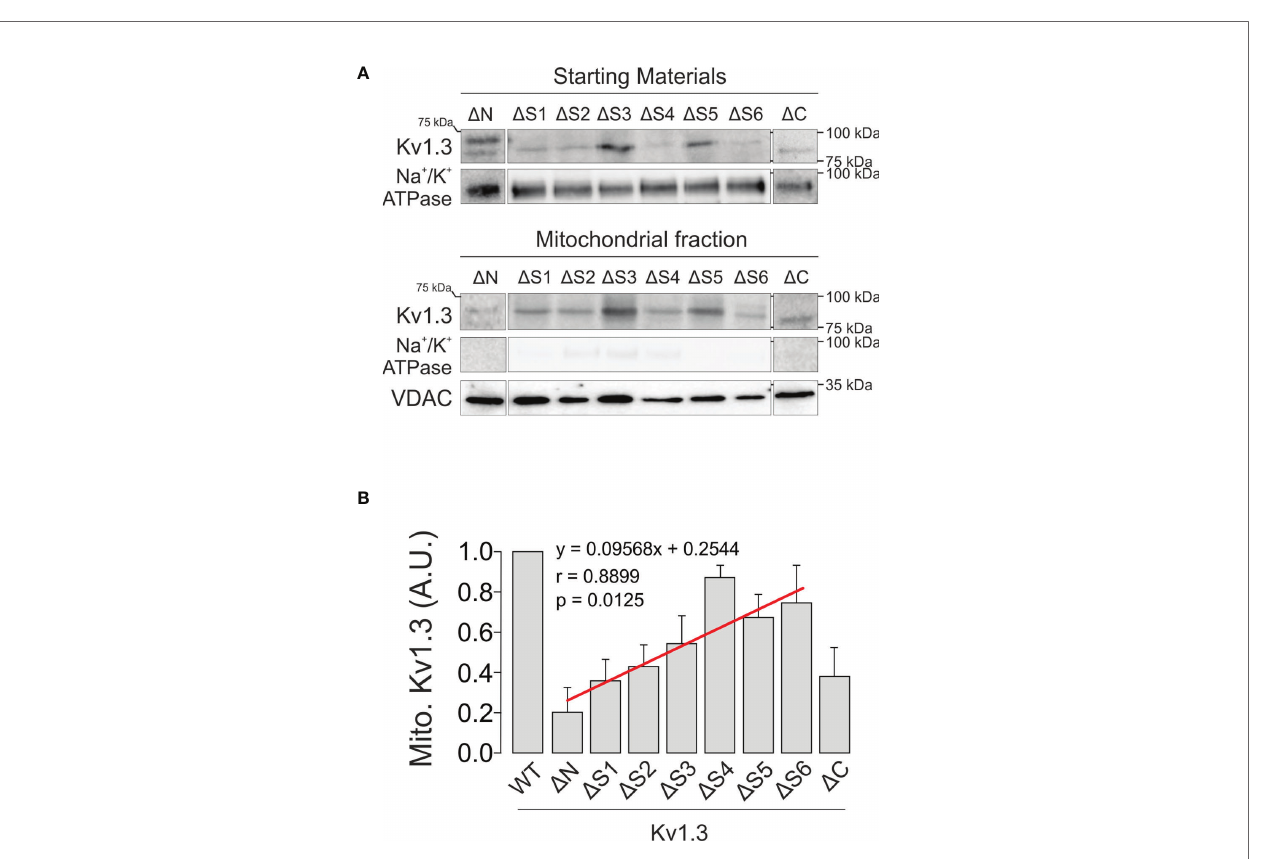
FIGURE 6 | Sequential deletion of Kv1.3 segments results in differential mitochondrial targeting. HEK 293 cells were transfected with several Kv1.3- D x channels, and mitochondrial expression was studied. (A) Representative immunoblot showing puri fi ed mitochondrial fractions (bottom panels) from total lysates (starting materials) of HEK 293 cells transfected with Kv1.3- D x. Samples were immunoblotted with antibodies against YFP (Kv1.3), Na + /K + ATPase (membrane marker) and VDAC (mitochondrial marker). (B) Relative mitochondrial Kv1.3- D x expression. Data are presented as the means ± SE (n=3-5). The linear regression shown in red (y=0.09568x+0.2544) had a Pearson ’ s correlation coef fi cient of r=0.8899 (p=0.0125). Kv1.3- D C was not included in the calculation because of its substantial mitochondrial-independent ER retention